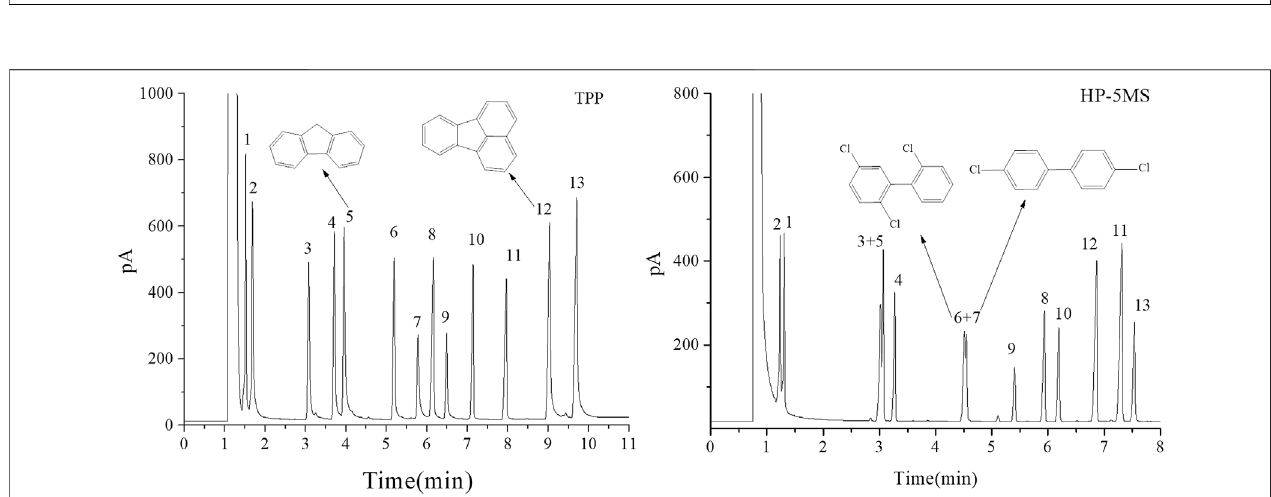
FIGURE 9 | GC separation of the mixture of PCBs, PAHs, PAEs, and n-alkanes on the TPP column and HP-5MS column. Peak: (1) n-dodecane, (2) naphthalene, (3) diethyl phthalate, (4) 2,6-dichlorobiphenyl, (5) fl uorene, (6) 2,2 ʹ ,5-trichlorobiphenyl, (7) 4,4 ʹ -dichlorobiphenyl, (8) dibutyl phthalate, (9) 2,3,4-trichlorobiphenyl, (10) n-eicosane, (11) dipentyl phthalate, (12) fl uoranthene, (13) pyrene. Temperature program: 160 ° C (1 min) to 260 ° C at 10 ° C min − 1.